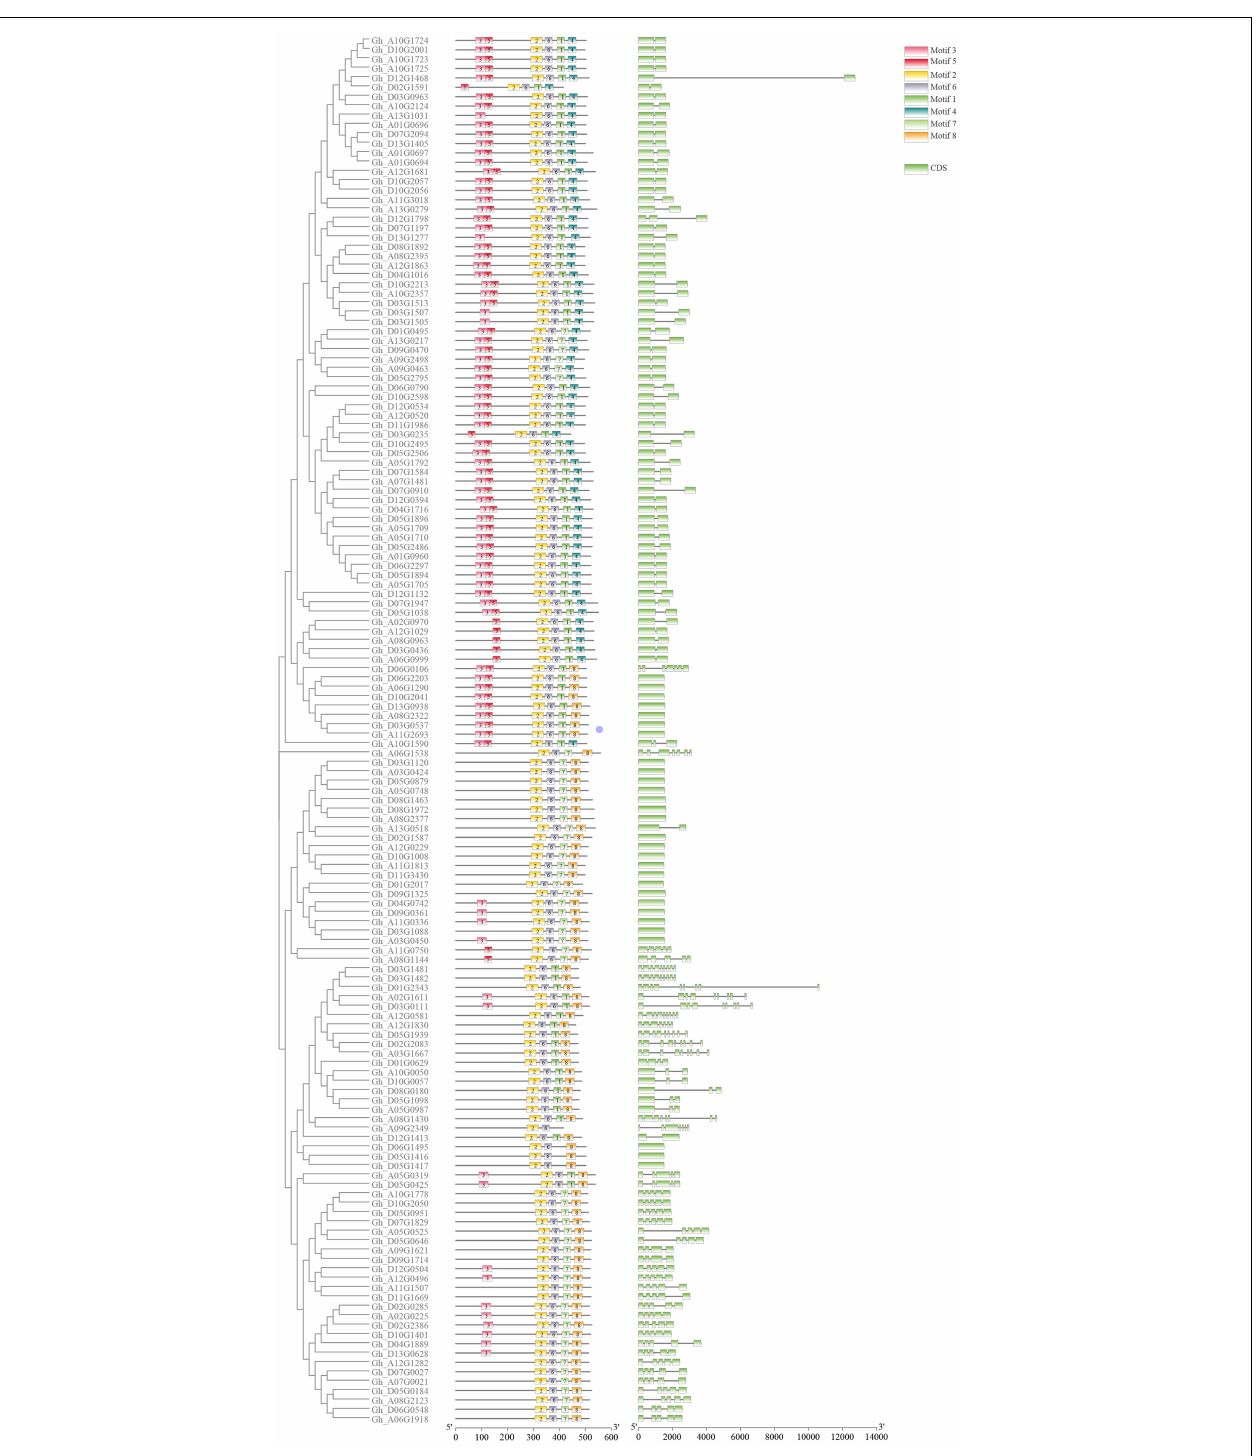
domain for almost all the identified P450 family genes. The overall expression pattern of the first subgroup of motifs was